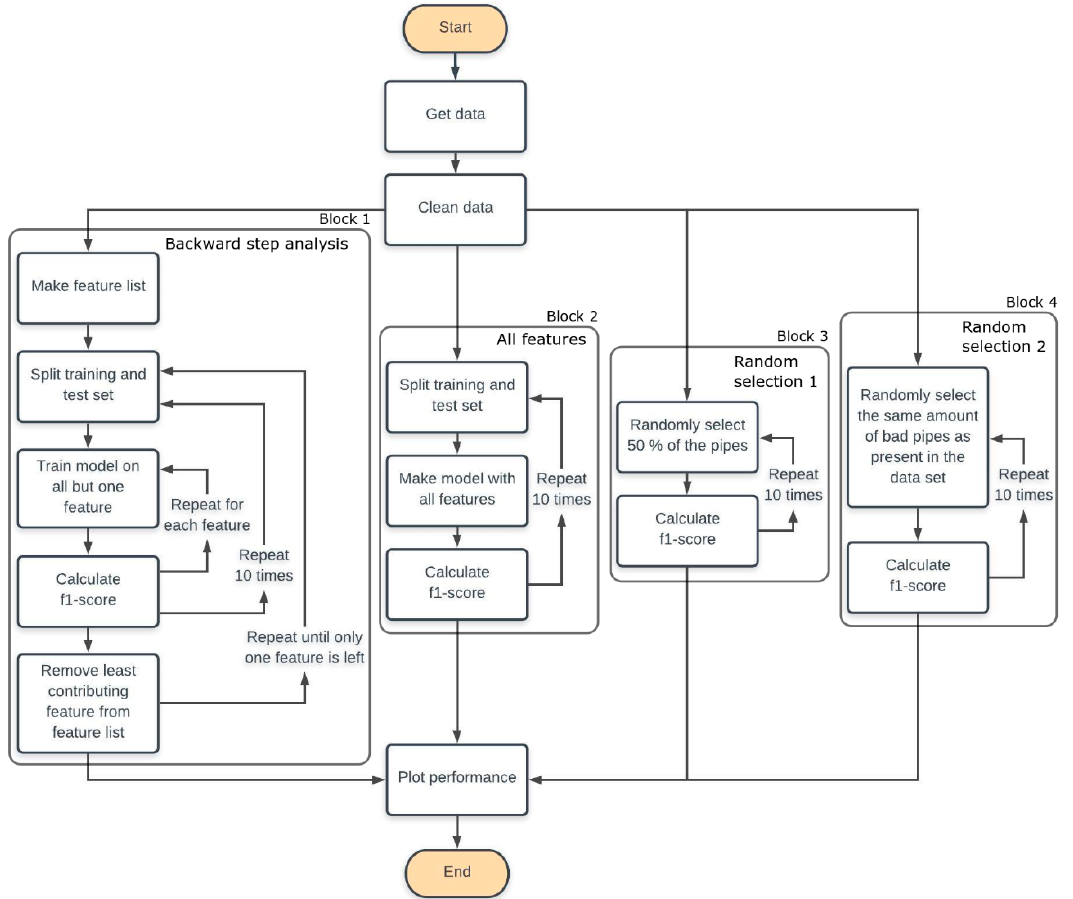
Figure 1. Feature step analysis when removing the features with the smallest contribution one by one. Block 1 shows the backward step analysis, block 2 shows the method for calculating the performance using all features, block 3 shows the method for calculating the performance when randomly selecting 50% of the pipes, and block 4 shows the method for calculating the performance when randomly selecting the same number of bad pipes as present in the dataset.